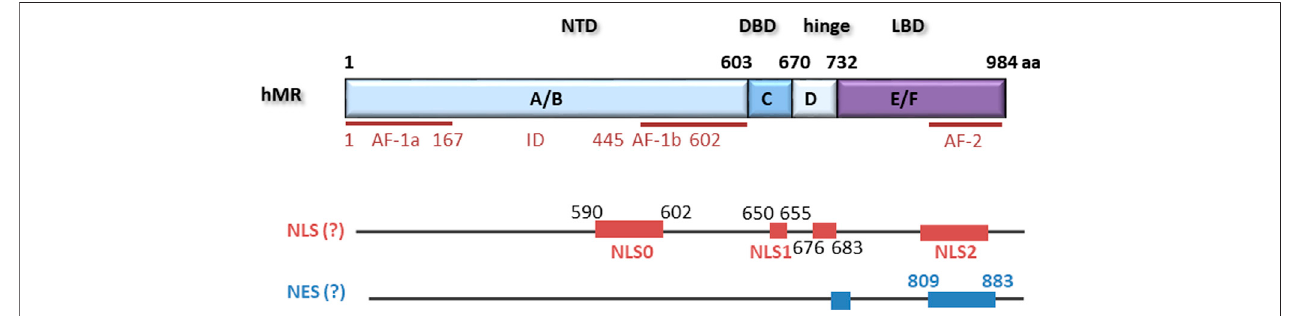
FIGURE 1 | hMR comprises 984 amino acids with an N-terminal domain (NTD), a DNA-binding domain (DBD), a hinge region and a ligand binding domain (LBD). Located within the NTD is an activation function 1 (AF-1) that is divided by an inhibitory domain (ID) into two parts, AF-1a and AF-1b. AF-2 is located in the LBD. Several nuclear localization signals (NLS) and putative nuclear export signals (NES) have been